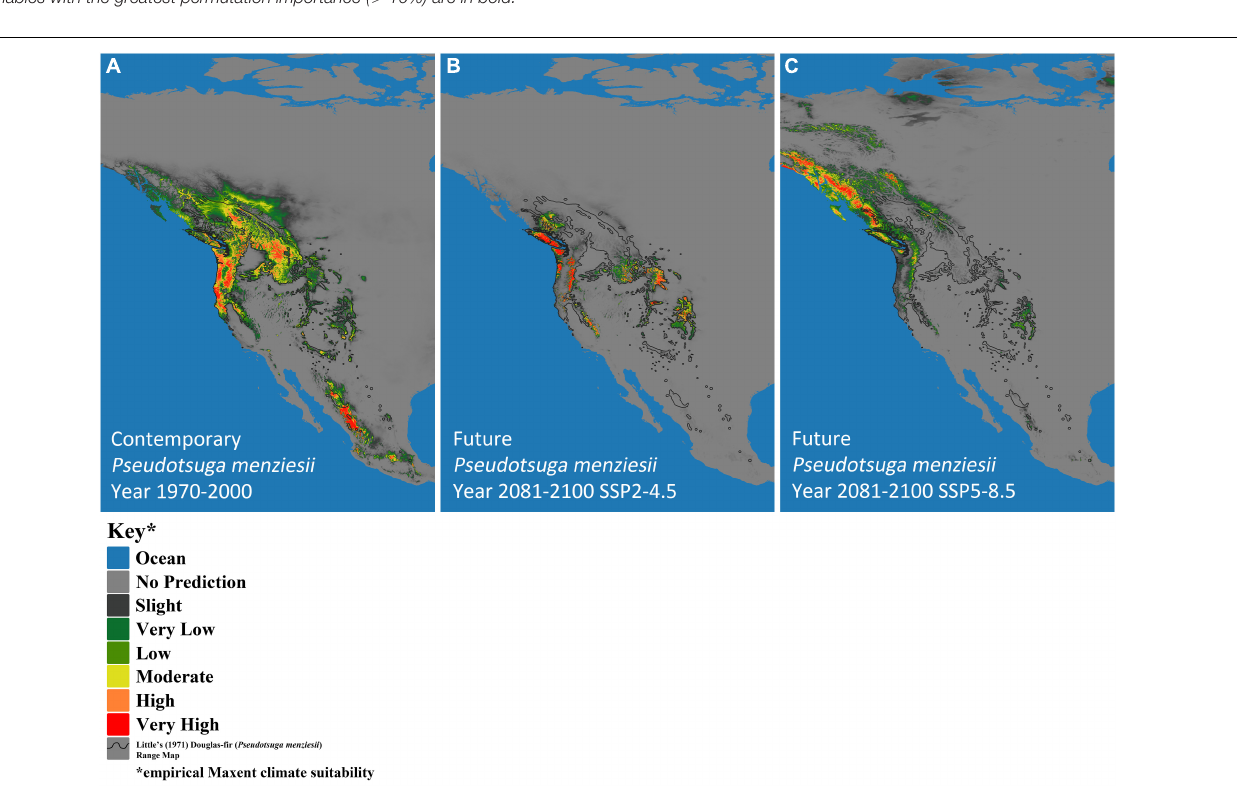
FIGURE 2 | MaxEnt-based, bioclimatic models for Pseudotsuga menziesii (Douglas-fir) in western North America. (A) Contemporary years (1970–2000), and two future models show two Shared Socioeconomic Pathway (SSP) scenarios (SSP2-4.5 and SSP5-8.5), (B) SSP2-4.5 and (C) SSP5-8.5. Darkest gray represents predicted empirical MaxEnt climate suitability, with dark green, light green, yellow, orange, and red indicating increased probability of climatic suitability, respectively. The black outline designates Little’s (1971) P . menziesii range map.